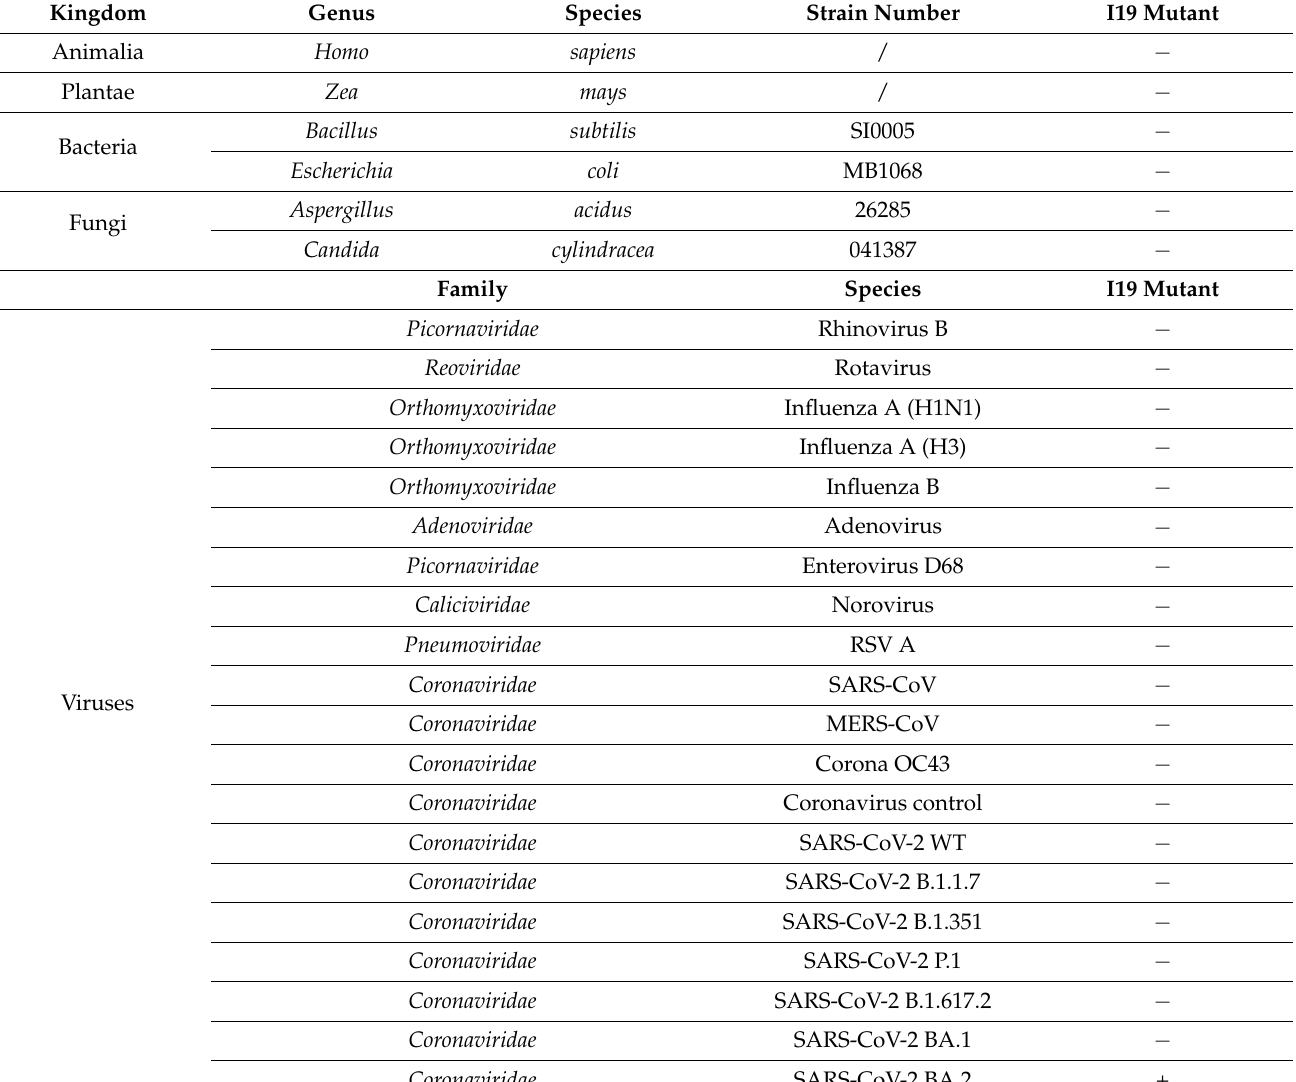
Table 5. Specificity assessment of the T19I assay. The absence and presence of amplification are symbolized by a “ − “ or “+”, respectively. The RT-ddPCR method was performed in duplicate on each sample. As positive control SARS-CoV-2 RNA from the BA.2 variant was